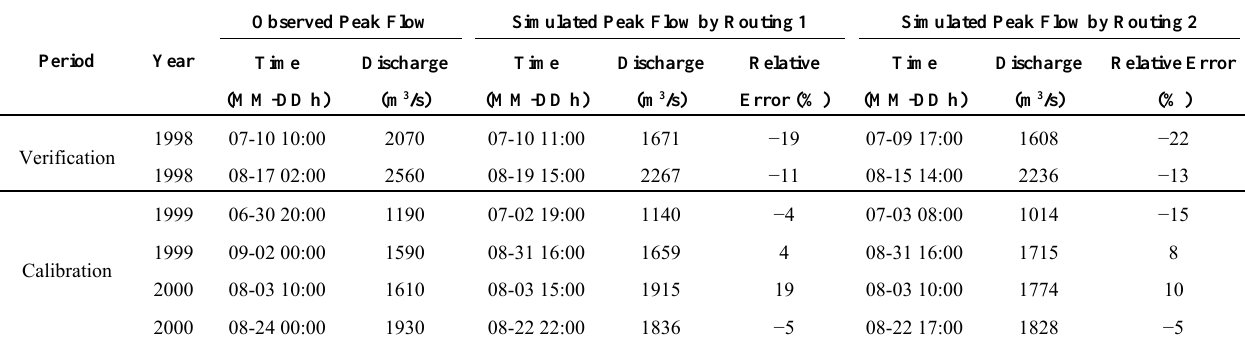
Table 4. Simulation results for major flood peaks at Lhasa